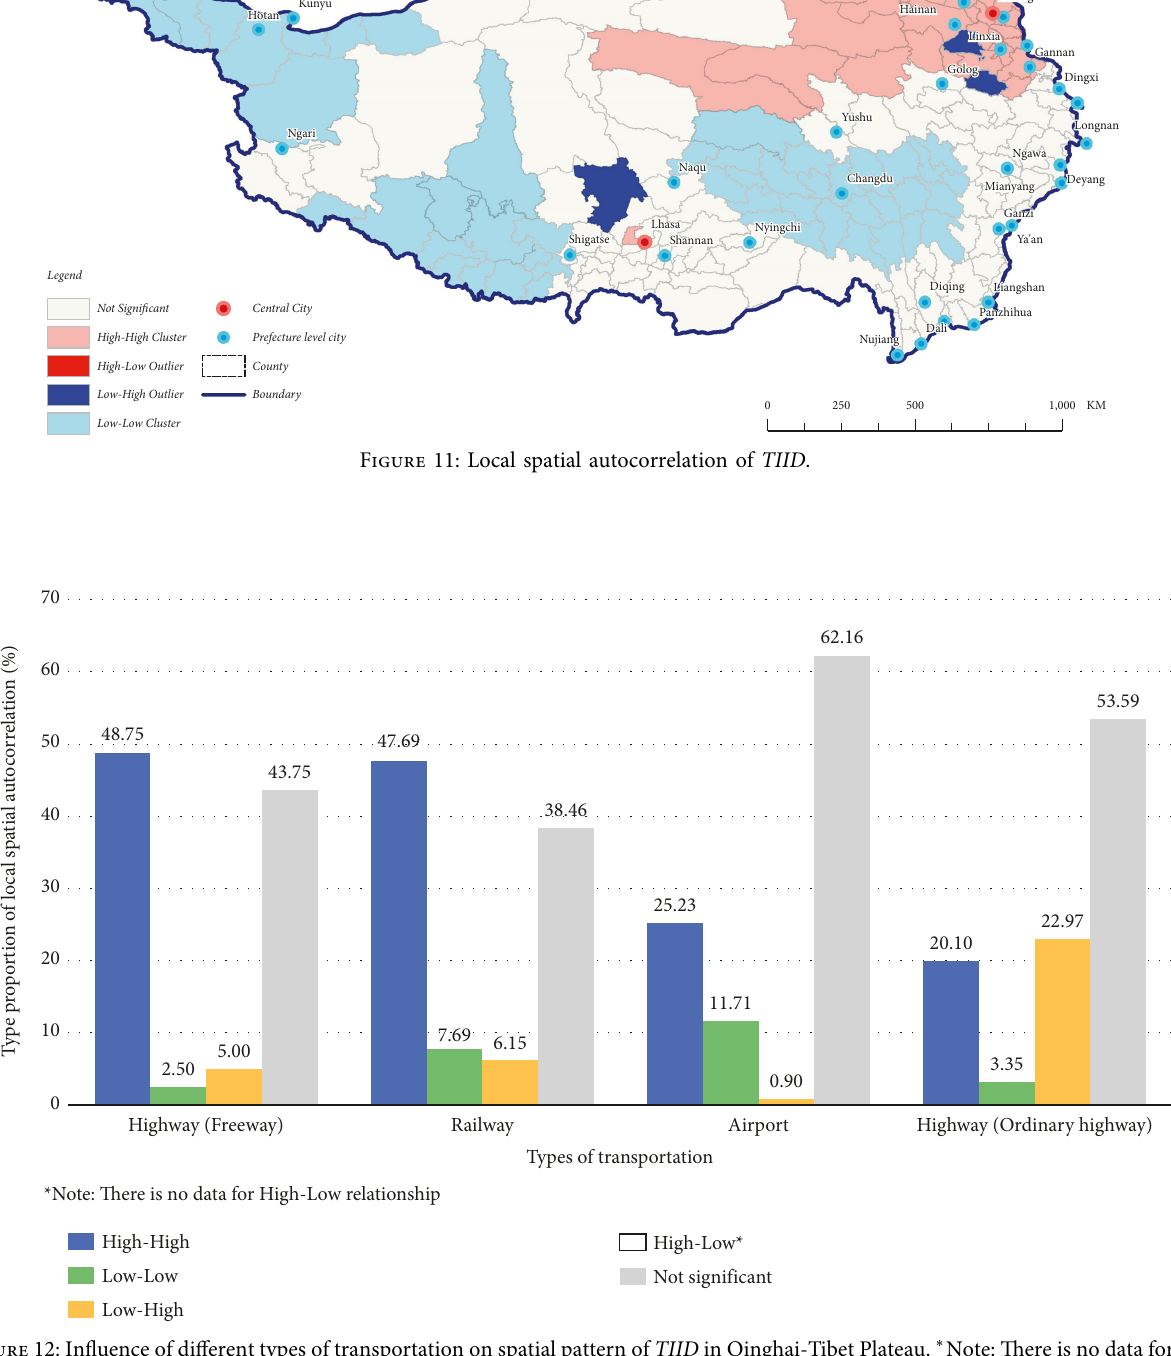
Note: There is no data for the ∗